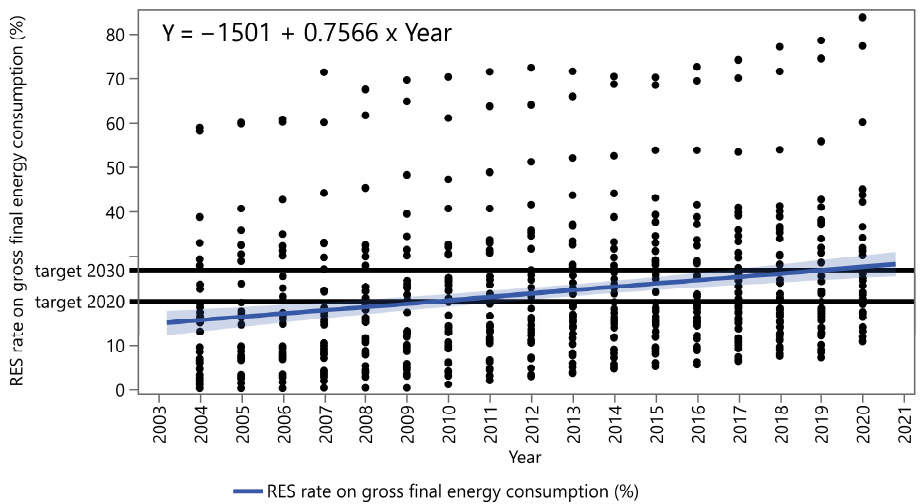
Figure 10. RES rate on final energy consumption in EU member states in 2004–2016. Source: own